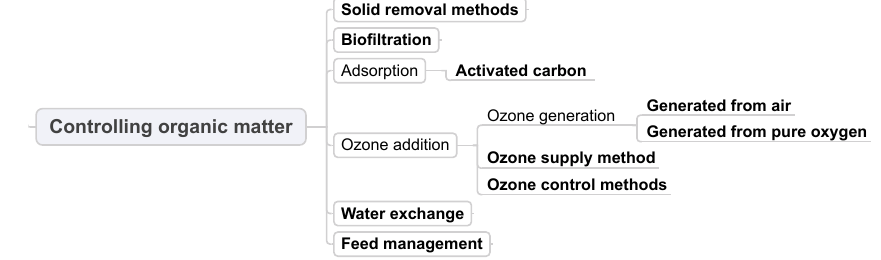
Figure 6. Taxonomy: controlling organic